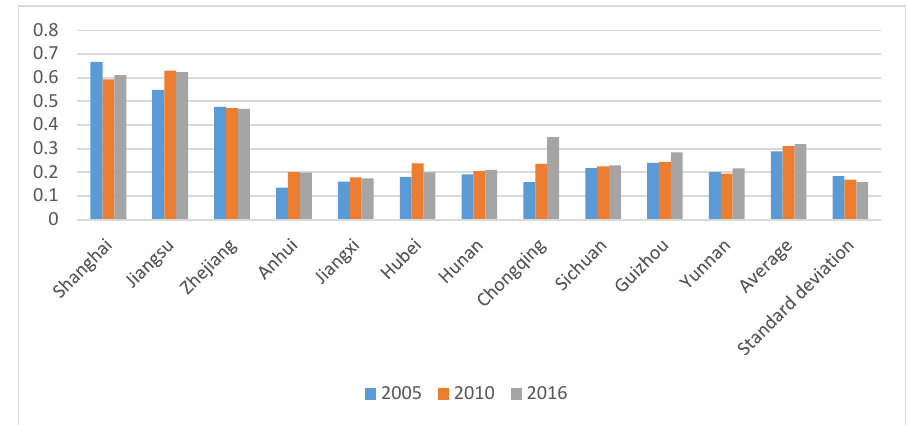
Figure 2. Comprehensive score of CERC.